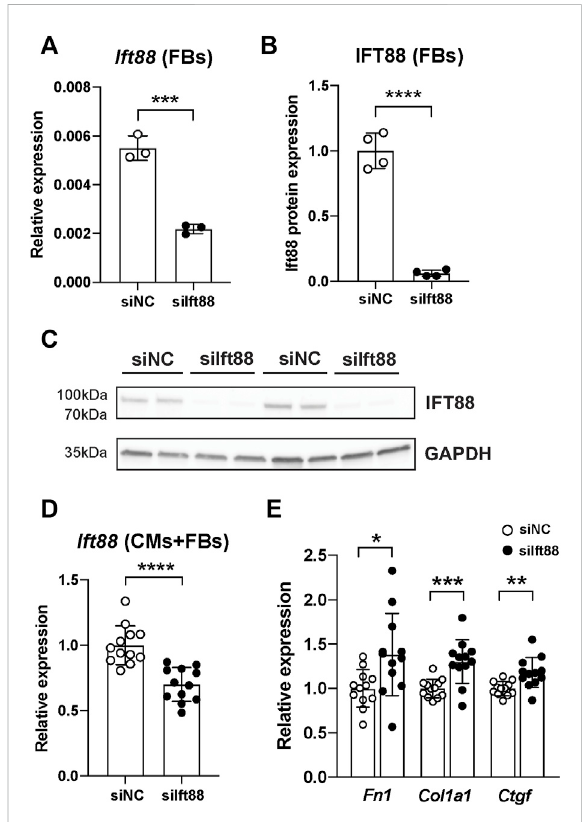
FIGURE 1 Reduction of Ift88 expression in FB leads to increased ECM genes expression in CM and FB co-culture. (A) Relative expression of (mRNA) Ift88 in FB previously transfected with siNC or siIft88. Data are mean ± SD. n = 6 from tree independent CM/FB isolation, Student ’ s t -test. (B,C) Relative expression of (protein) IFT88 in FB previously transfected with siNC or siIft88. Data are mean ± SD. n = 4 from two independent CM/FB isolation, Student ’ s t -test. Full unedited blots are provided in Supplementary Figure S1. (D) Relative expression of (mRNA) Ift88 in CM-FB co- cultures after FB transfection with siNC or siIft88. Data are mean ± SD. n =12fromfourindependentCM/FBisolation,Student ’ s t -test. (E) Relative expression of ECM genes Fn1 , Col1a1 and Ctfg after 48 hofco-cultureofCM-FB.Dataaremean±SD. n